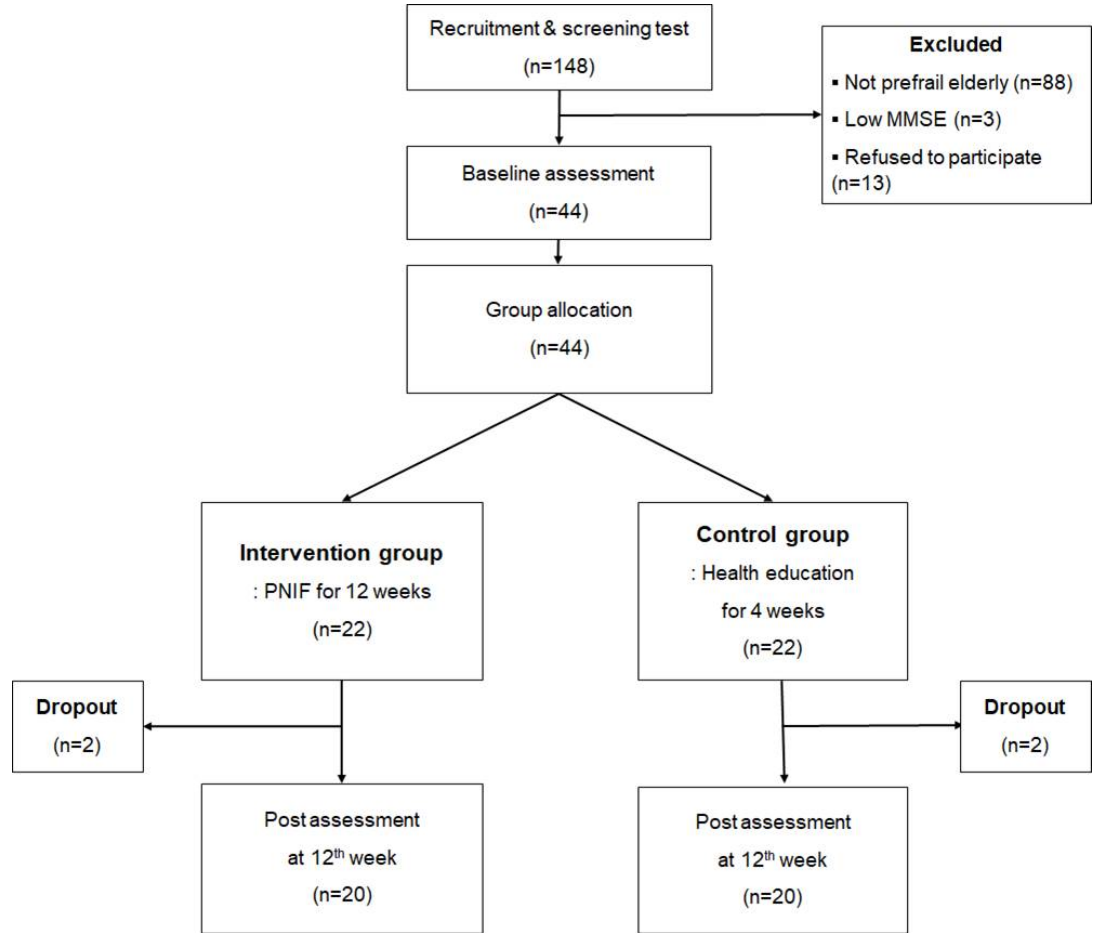
Figure 1. Flow diagram of this study.